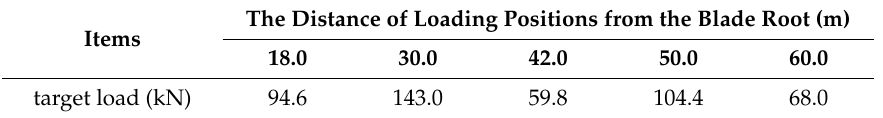
Table 1. The target load of each loading point.